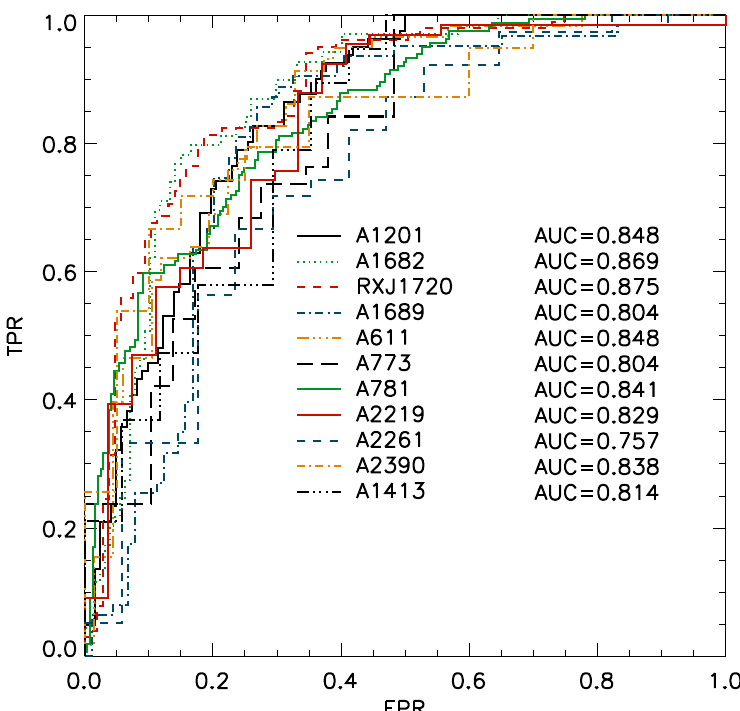
Figure 4. The ROC curve variations of individual clusters. Note that the training is conducted using all clusters combined, but the validation is performed separately for each cluster in this plot.